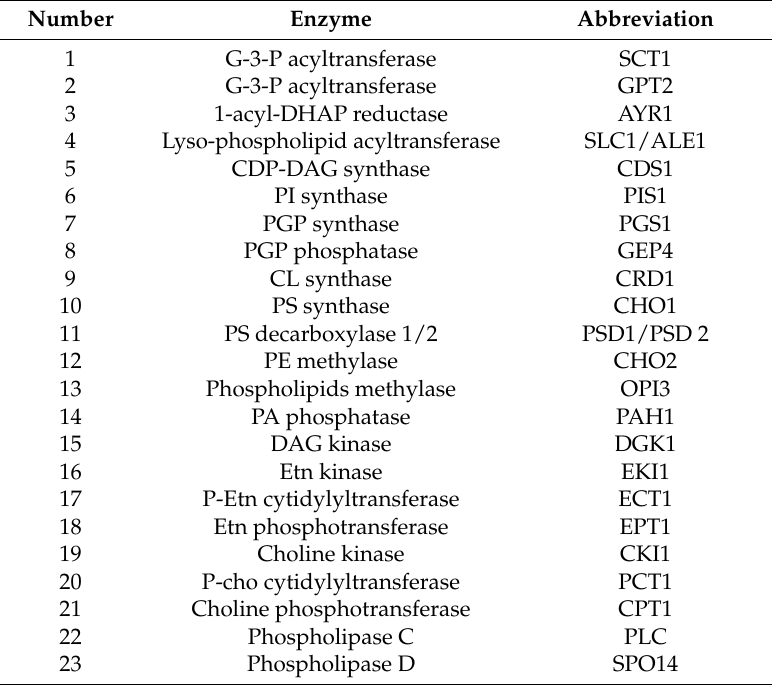
Table 2. Enzymes catalyzing phospholipids metabolism in S. cerevisiae